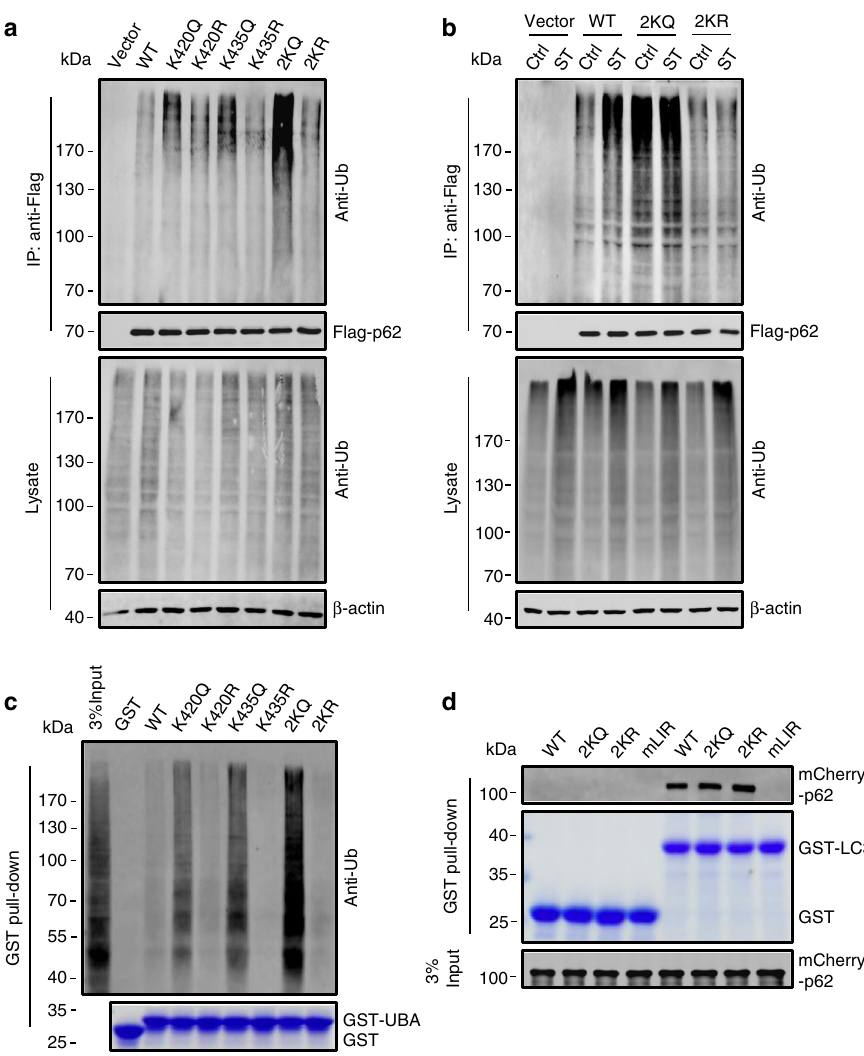
Fig. 5 Acetylation promotes p62-ubiquitin binding. a , b Co-precipitation of ubiquitylated proteins with Flag-p62. Flag-p62 was immunoprecipitated by anti-Flag from p62 -KO HEK293 cells transiently expressing Flag-tagged WT p62 or each of the p62 mutants and co-precipitated ubiquitylated proteins were detected using anti-Ub. 2KQ, both Lys420 and Lys435 residues were replaced by Gln. c GST pull-down assay of the binding of p62-UBA and ubiquitylated proteins. Cell lysates of MG132-treated HeLa cells were incubated with puri fi ed GST-tagged UBA of WT p62 or each of the indicated p62 mutants. The GST-UBA-bound ubiquitylated proteins were detected using anti-Ub. d GST pull-down assay showing the interaction of puri fi ed GST-LC3B and puri fi ed mCherry-tagged WT or mutant p62 proteins. mLIR: p62 with LIR mutation. Source data are provided as a Source Data fi